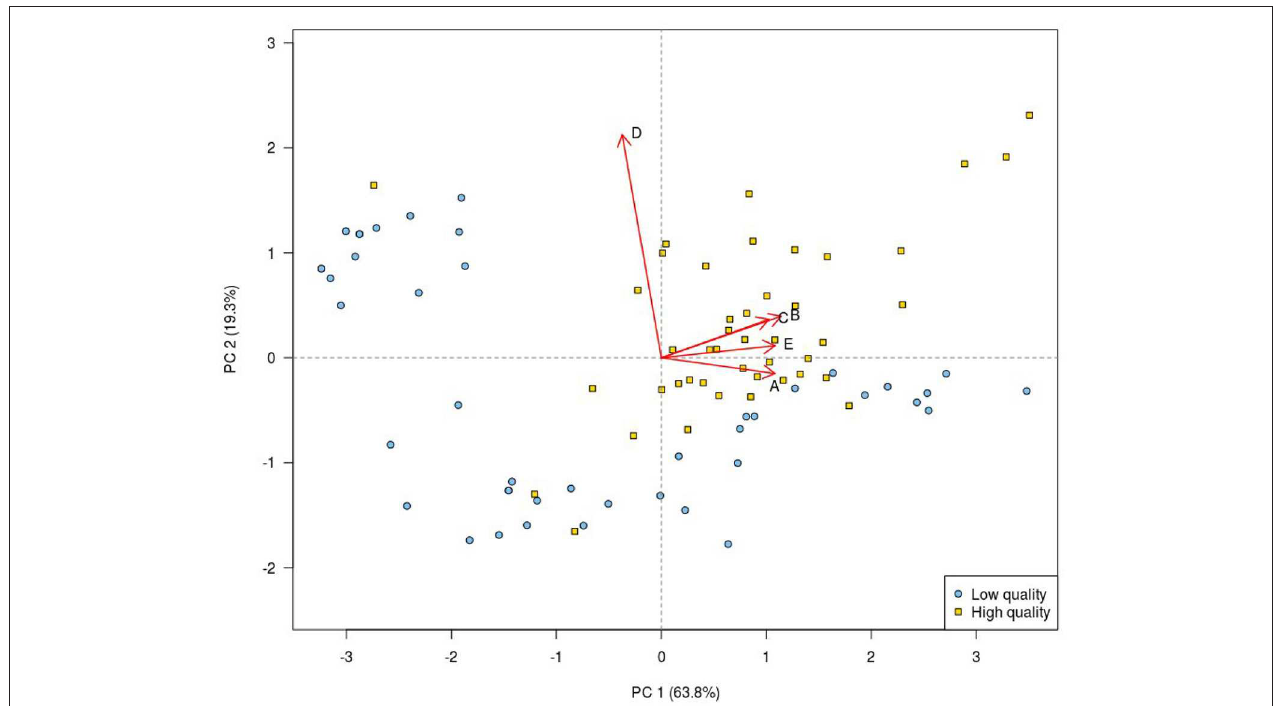
FIGURE 2 | Principal component analysis biplot of the VGA results. Each plotting character represents a single image. Principal component analysis scores for the high quality images (yellow squares) are grouped in the upper right quadrant, while PCA scores for the low quality images (blue circles) mainly occupy the remaining quadrants. This indicates that the VGA appears successful in separating the two image groups. The first (PC 1) and the second (PC 2) principal components taken together describe 83.1% of the variation in the data. The loadings (red arrows) show the contribution of each image criterion and their degree of correlation. The biplot shows that image criteria A, B, C, and E were positively correlated, while there was poor correlation between the PCA scores for image criterion D and those of all other image criteria.